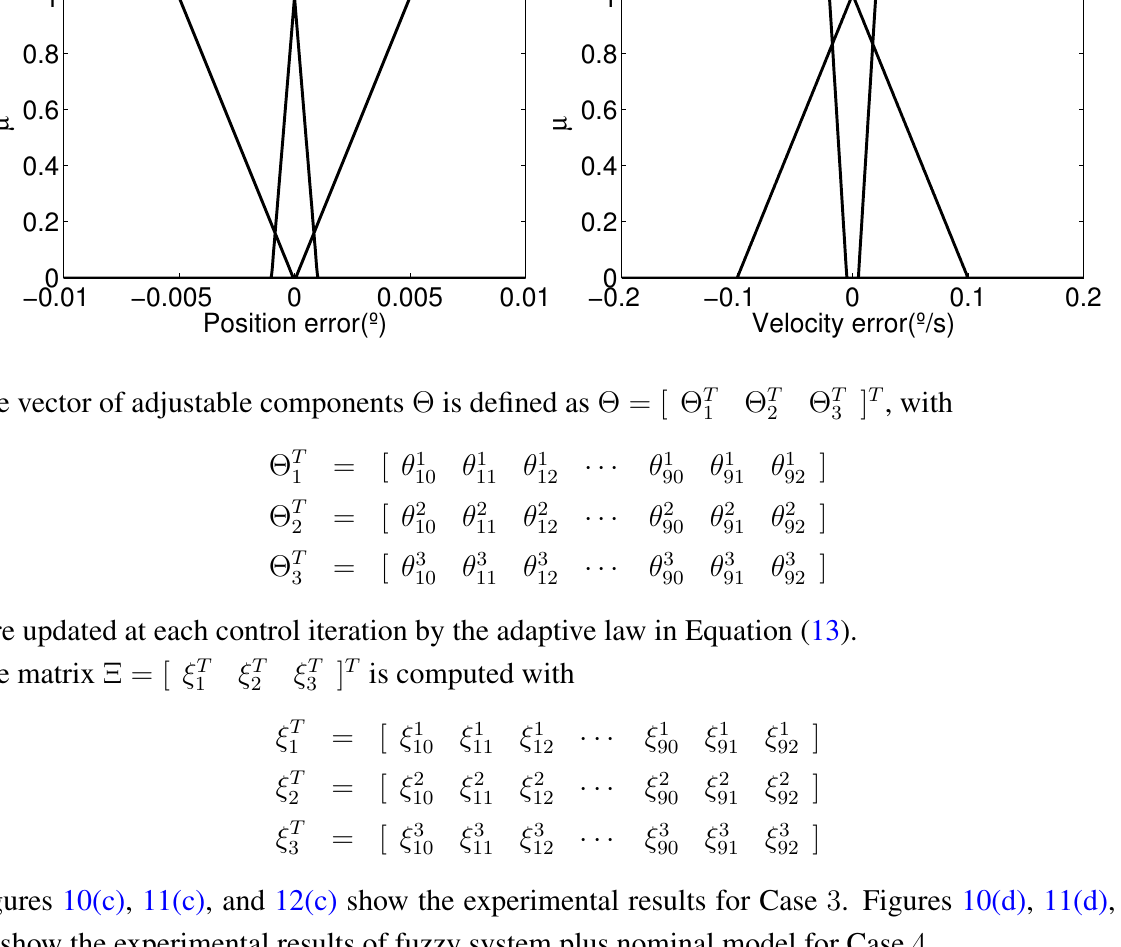
Figure 13. Fuzzy sets A